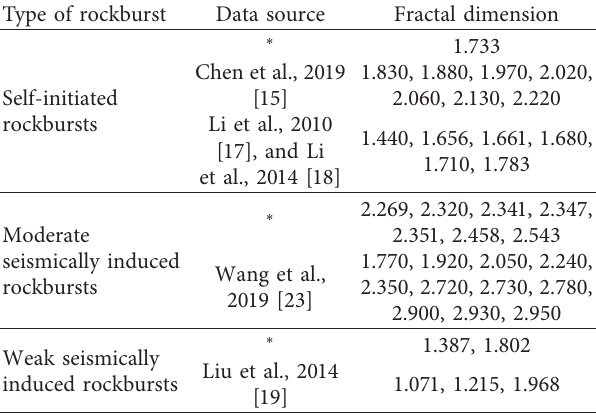
Table 2: Fractal dimensions of different types of rockbursts.